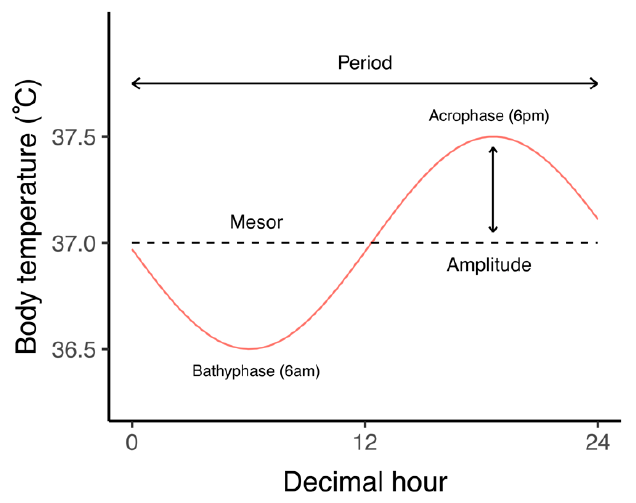
Figure 2. Circadian parameters of the body temperature. The graph represents the circadian rhythm of the body temperature (red curve). The dashed line represents the mesor (MESOR = Midline Estimating Scheme 24 h for a circadian rhythm). The amplitude is the difference between the mesor and the value at the peak. The acrophase is the time-of-day of the maximum value. The bathyphase is the time-of-day of the minimum value.